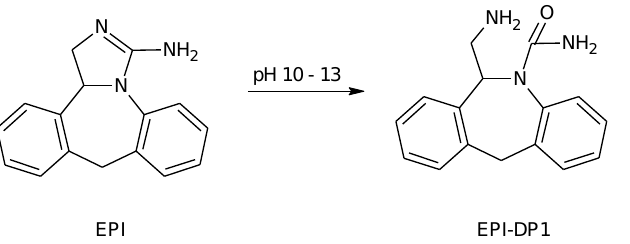
Figure 10. Proposed degradation pathway of epinastine (EPI) in alkaline conditions at 70 °C.